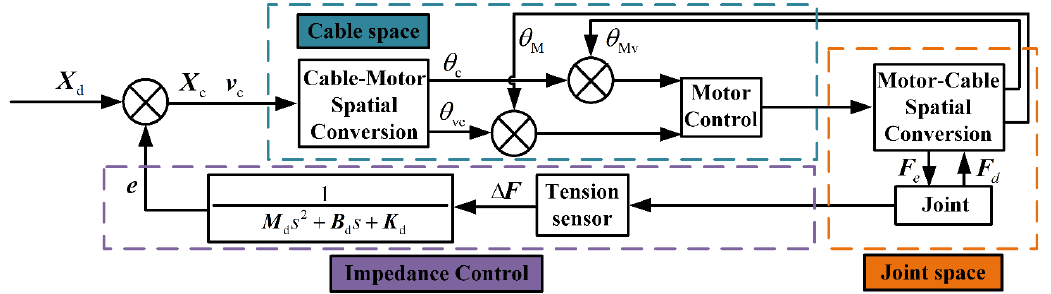
Figure 7. Position-based impedance control system.